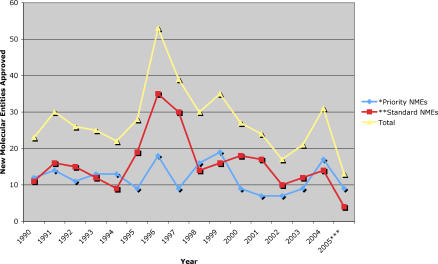
New Drug Approvals at the FDA*Priority NMEs are new molecular entities that represent a significant improvement compared with marketed products in the treatment, diagnosis, or prevention of a disease.**Standard NMEs are new new molecular entities that appear to have therapeutic qualities similar to those of one or more already marketed drugs.***Data through Nov 30, 2005.Note that in 2004, the FDA began including biologics in with its new drug approval data. These data have been excluded from this chart. In 2004, there were four priority biologics and one standard biologic approved by the FDA; in 2005 through November 30, 2005, there was one priority biologic and no standard biologics approved by the agency.